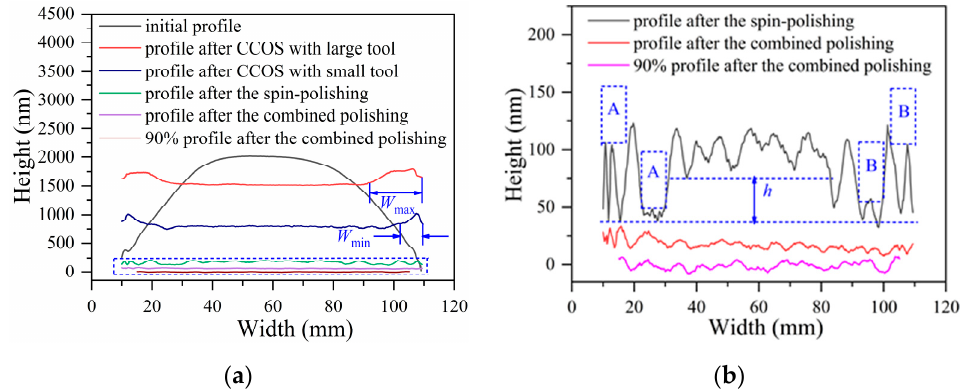
Figure 8. Surface profile after different machining processes. ( a ) profile comparison at different processing stages, ( b ) amplified view of the dashed part in ( a ).